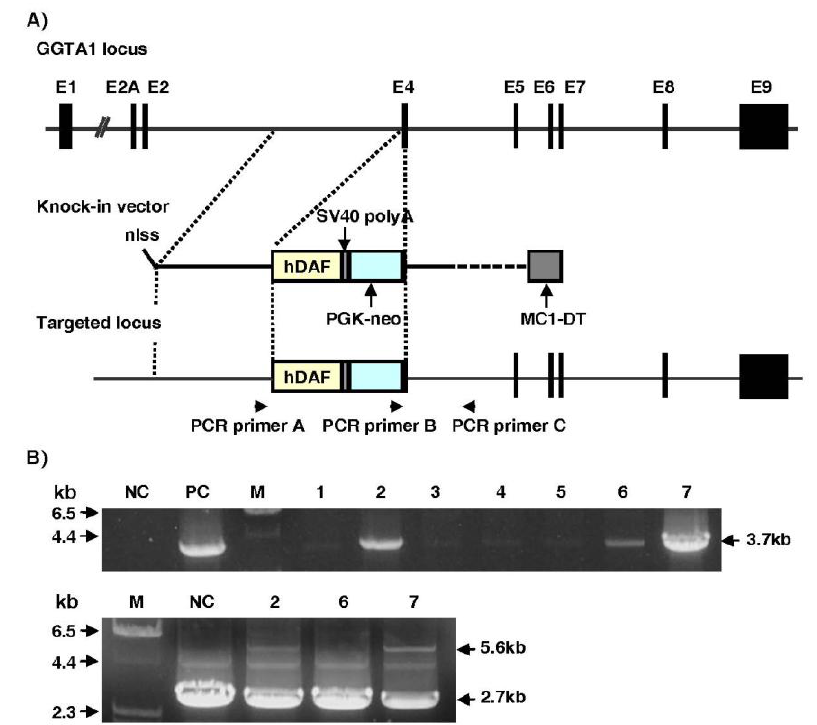
Figure 1. Gene targeting of the GGTA1 locus using knock-in vector. (A) Diagram indicating homologous recombination of knock-in vector at the porcine GGTA1 locus. The PCR primer pairs used for detection of homologous recombination are shown as primer A, B, and C. (B) Representative EtBr stained agarose gel of 1st PCR amplicons (upper panel) from primer B and C, and 2nd PCR amplicons (lower panel) from primer A and B of G418-resistant colonies selected from a transfection with linear knock-in vector. M = size marker (  /HindIII); NC = Negative control; PC = Positive control; Number = G418-resistant